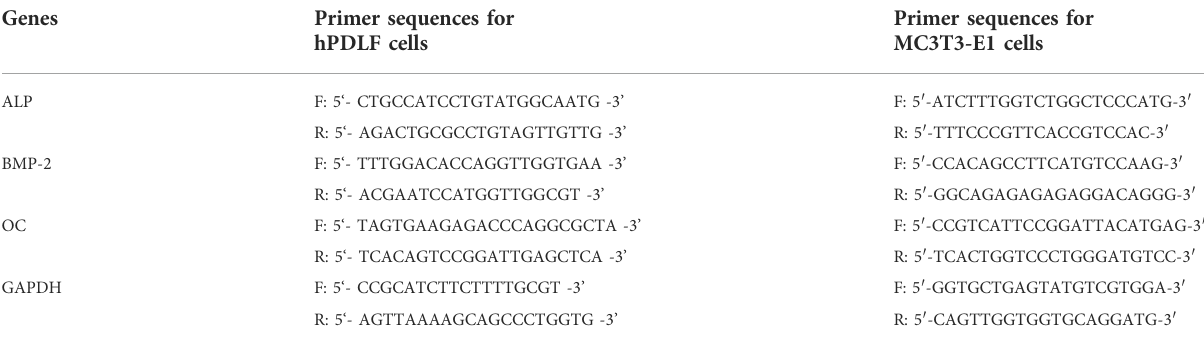
TABLE 1 List of primers used for RT-PCR analysis of hPDLF cells and MC3T3-E1 cells F: Forward, R: Reverse, ALP: Alkaline phosphatase, OC: Osteocalcin, BMP-2: Bone morphogenetic protein-2, GADPH: Glyceraldehyde-3 phosphate dehydrogenase. Genes Primer sequences for hPDLF